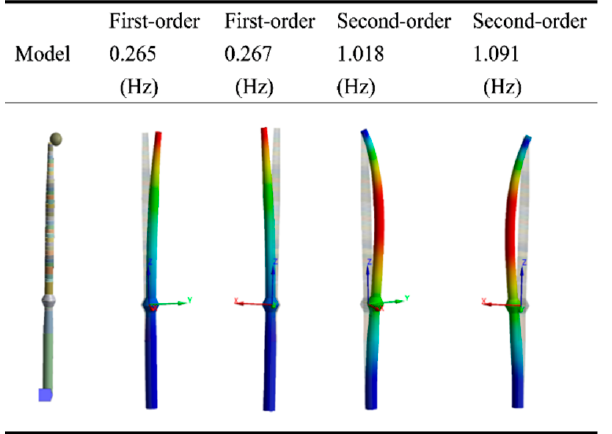
Figure 13. FEM model and modal analysis results for the OWT. The first-order mode of the OWT swings in the directions of the X -axis and Y -axis, and the natural frequency is approximately 0.265 Hz. The calculated first frequency was close to the actual frequency (0.26 Hz), and the second frequency was approximately 1.02